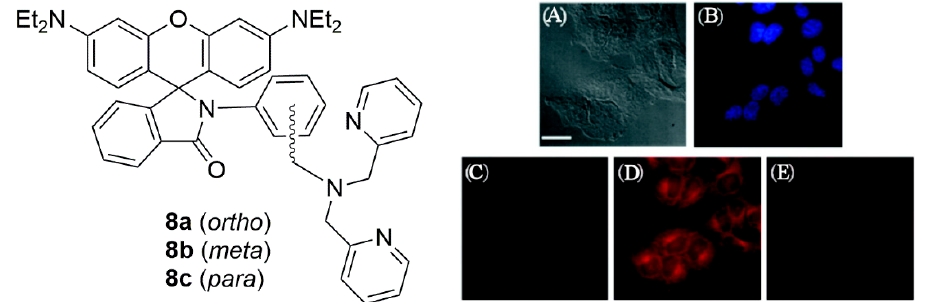
Figure 3. Live cell imaging of Hela cells after incubation with compound 8a (10 µ M) and Hoechst 33258 nuclear stain (blue): ( A ) Bright-field transmission image ( B ) Hoechst 33258 nuclear stain ( C ) fluorescence image without Zn 2 + ions ( D ) Cells incubated with 8a for 15 min, washed, and then treated with 50 µ M Zn 2 + pyrithione for 20 min. ( E ) 8a loaded plus Zn 2 + (50 µ M)-supplemented cells treated with 80 µ M TPEN after 10 min. Scale bar = 25 µ M. Adapted from [145], with permission from American Chemical Society.